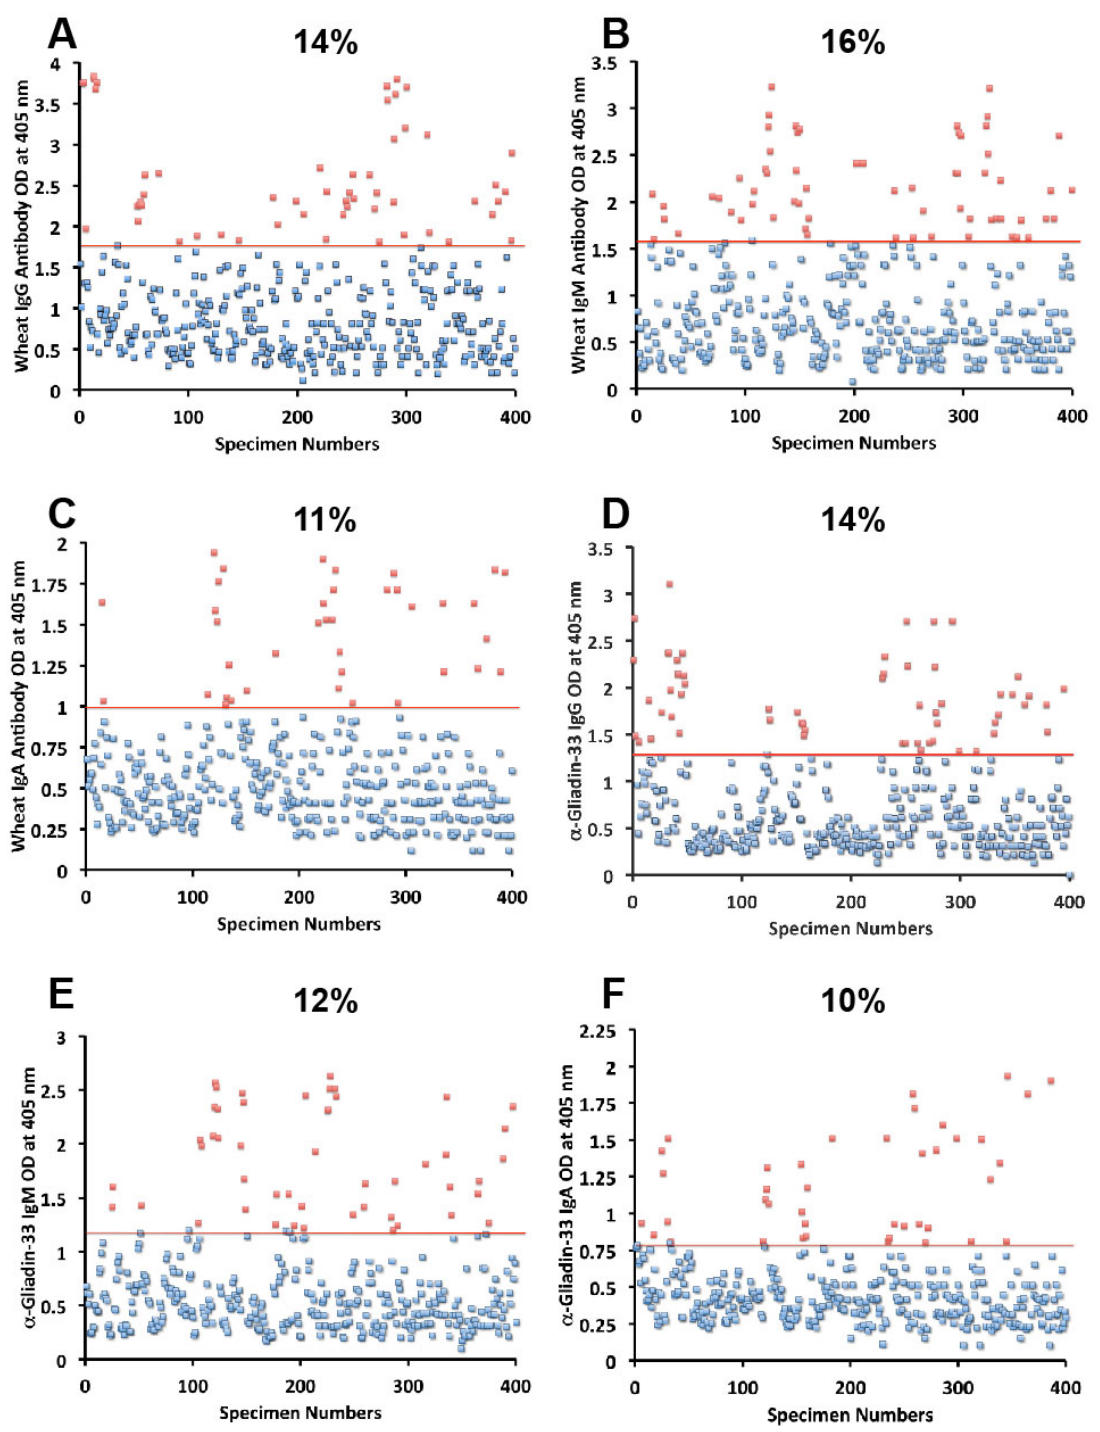
Figure 1. Results for wheat and α -gliadin-33 expressed as OD at 405 nm in the form of scattergrams with percentages of elevation. ( A ) Wheat IgG; ( B ) Wheat IgM; ( C ) Wheat IgA; ( D ) α -gliadin-33 IgG; ( E ) α -gliadin-33 IgM; ( F ) α -gliadin-33